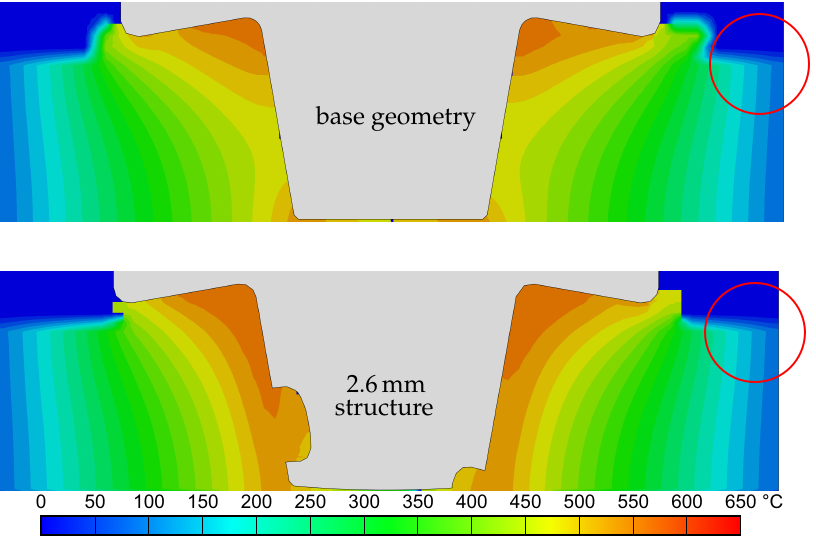
Figure 14. Comparison of temperature profiles and gradients in cross-section for base geometry ( top ) and fifth design iteration ( bottom ), e.g., with and without active material flow